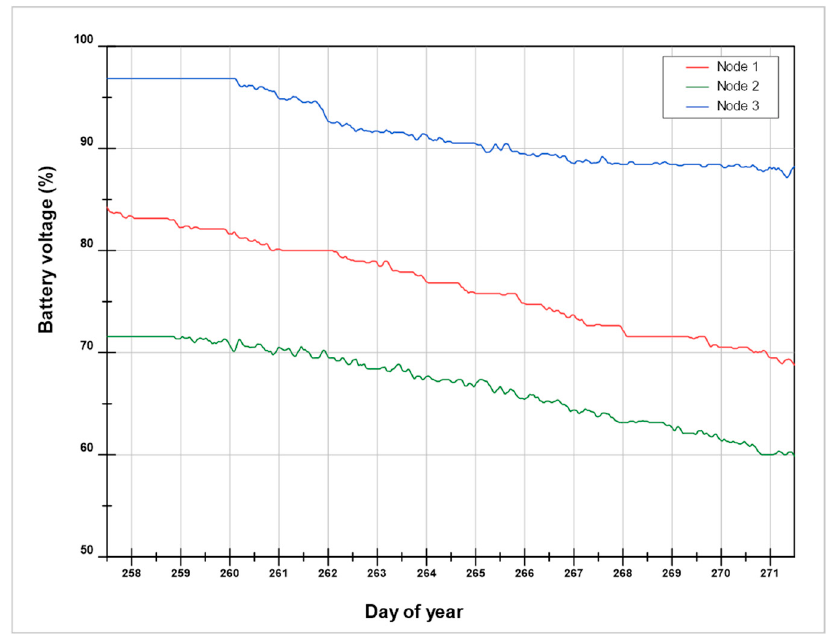
Figure 14. Trial 6: voltage evolution of the three nodes distributed in several places inside of the refrigerated truck container.